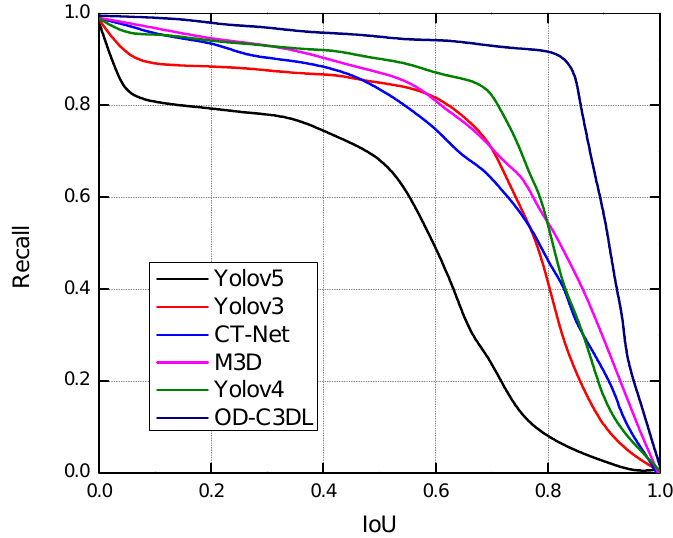
Figure 8. Comparative analysis of OD-C3DL with existing mechanisms for measuring the recall by varying the IoU.